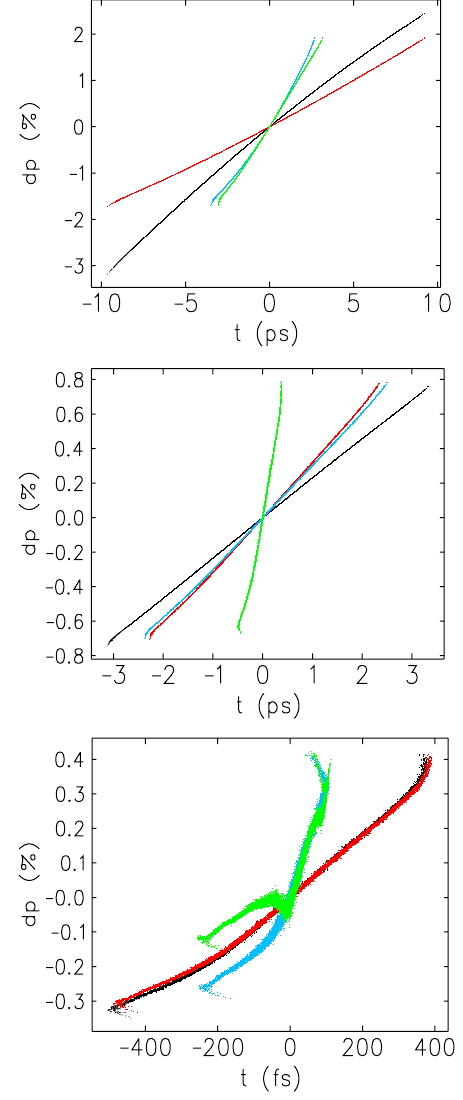
FIG. 11. Longitudinal phase space at progressing through the linac. Top: Sections at 228 MeV (black—after second module; red—after third harmonic cavity; blue—after first bunch com- pressor; green—after injection achromat). Middle: Sections at 1227 MeV (black—after linac-to-arc achromat; red—at exit of arc 2; blue—after arc-to-linac matching achromat; green—after bunch compressor 2). Bottom: Sections at 2244 MeV (black— after linac second pass; red—after extraction; blue—after bunch compressor 3; green—after spreader and on entrance to FEL).